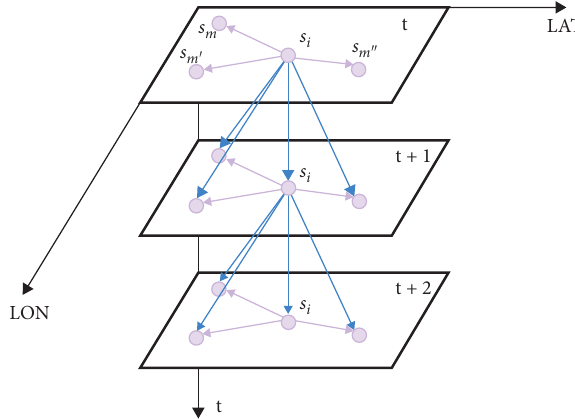
Figure 8: Spatiotemporal anomaly diffusion